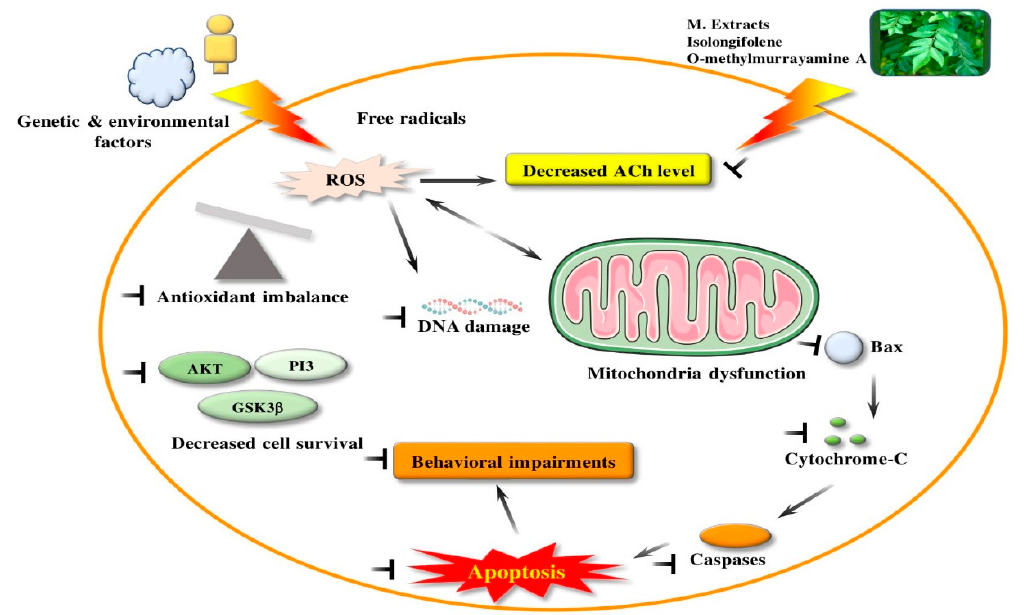
Figure 3. Neuroprotective effect in in vitro and in vivo studies produced by bioactive compounds from M. koenigii. PI3: phosphatidylinositol 3 kinase; GSK3 β : Glycogen synthase kinase 3 beta; Ach: Acetylcholine; Bax: Bcl2-Associated X protein.